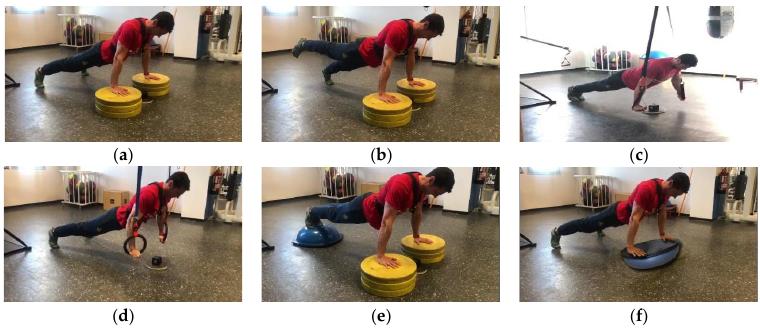
Figure 1. Different push-up settings during measurement: ( a ) stable; ( b ) monopodal; ( c ) suspension device: TRX ® ; ( d ) suspension device: rings; ( e ) with feet-on Bosu ® ; ( f ) with hands-on Bosu ® .